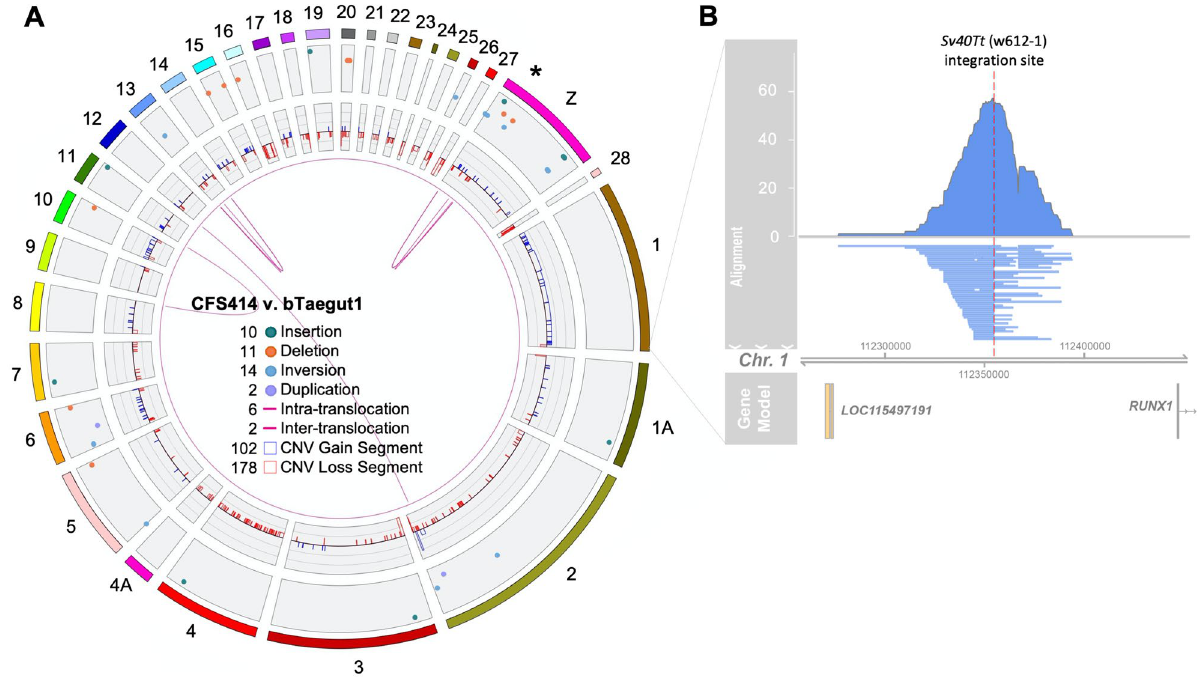
Figure 3. CFS414 cells are derived from a single transduction event. ( A ) Circos plot of CFS414 genome assembly compared to the bTaegut1 reference genome, showing large (≥ 150 kb) CFS414 structural variants, specified by the color legend in the center. * denotes highly variable region between the CFS414 and bTaegut1 Z chromosome. ( B ) Pileup of mapped Pacbio subreads containing the SV40Tt sequence from CFS414 cells, showing w612-1 proviral insertion in the intergenic space between RUNX1 and LOC115497191 on chromosome 1.